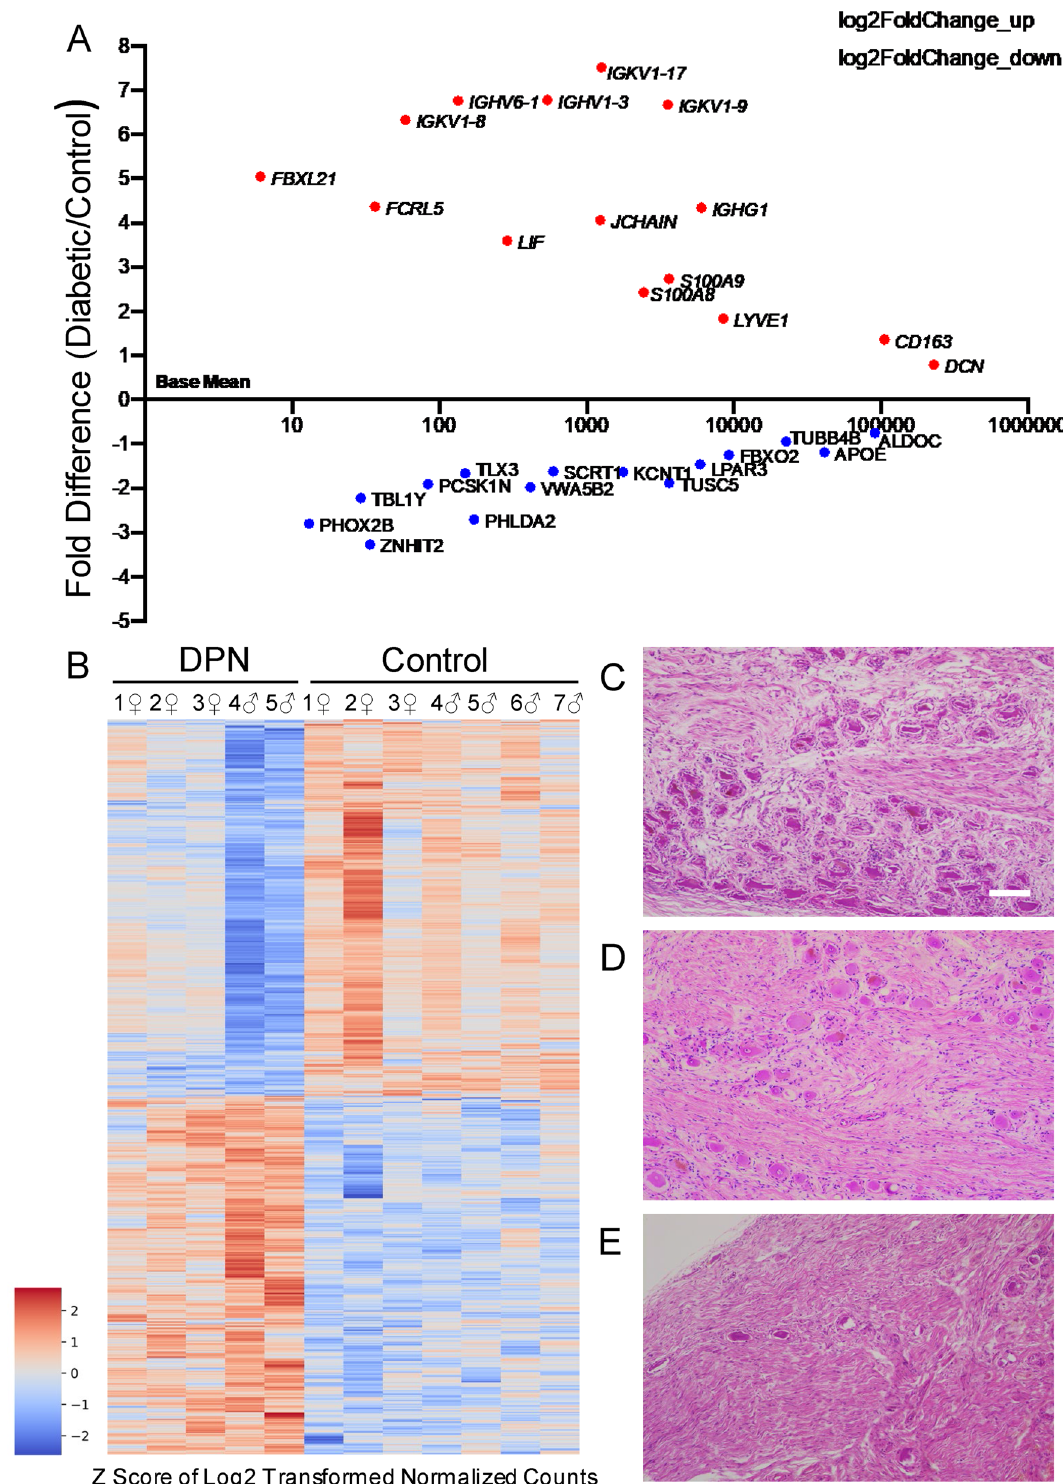
Figure 1. DPN Transcriptome: ( A ) Scatterplot of all DEGs where dysregulated genes with high log2 fold change per base mean of normalized DESeq2 counts are highlighted. Immunoglobulins and other inflammatory related genes are upregulated while some genes involved in neurogenesis like the transcription factors SCRT1 and TLX3 were downregulated in the diabetic individuals. ( B ) Heatmap of all 844 DEGs. ( C - E ) H and E images of the L4 DRG, scale bar = 500 µm; ( C ) Normal dorsal root ganglion with adequate density of ganglion cells surrounded by satellite cells, ( D ) DPN with a neuropathologist report of moderate loss of neuronal ganglion cells with replacement reactive fibrosis, and ( E ) DPN with a neuropathologist report of severe loss of neuronal ganglion cells with replacement fibrosis (hematoxylin and eosin stains at 40X